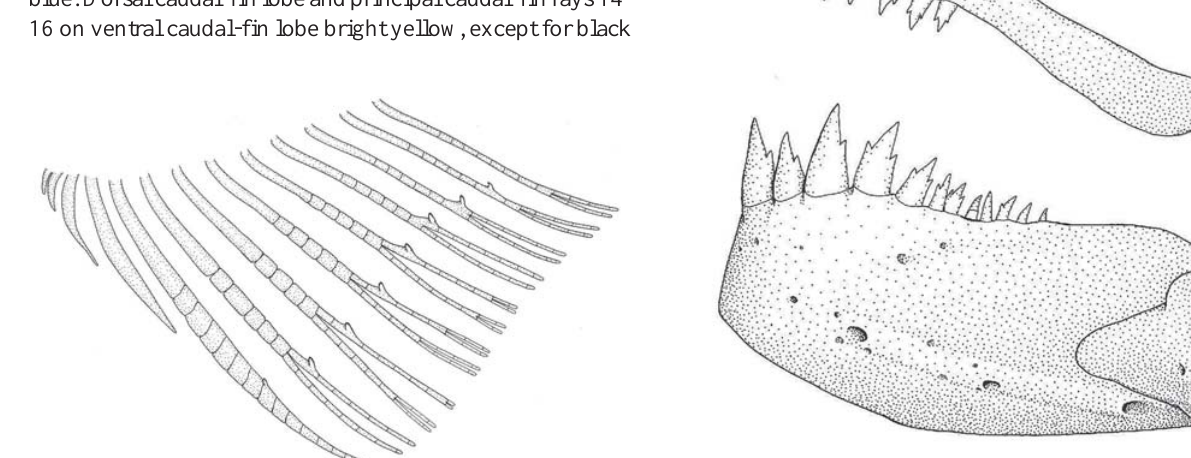
Fig. 41. Mimagoniates barberi , adult male, UMMZ 205420, 35.9 mm SL; jaws and dentition, lateral view, right side, anterior at